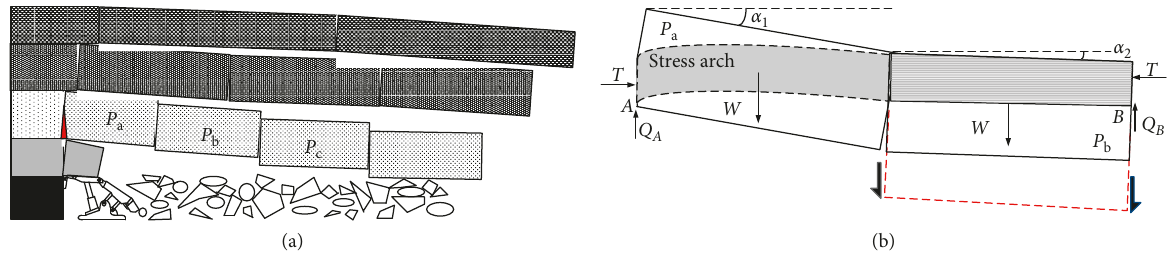
Figure 3: Step pressure-arch structure of key blocks of the periodic fractured roof. (a) Sketch map of the structure of key blocks. (b) Mechanical model.